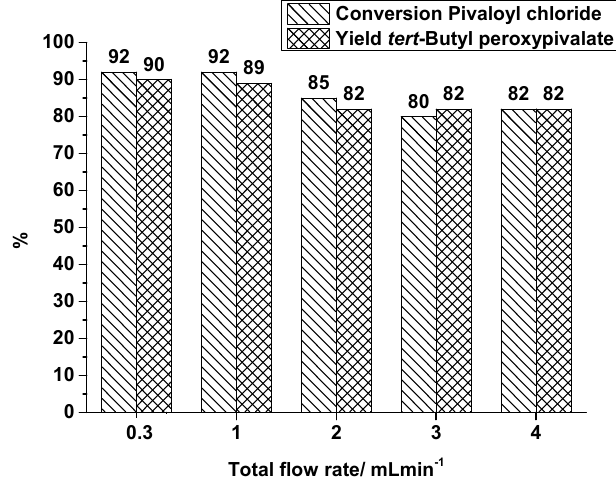
Figure 7. SAR reactor, conversion and yield of TBPP synthesis, 2nd reaction step at a reaction temperature of 40 °C in dependence on total flow rate.